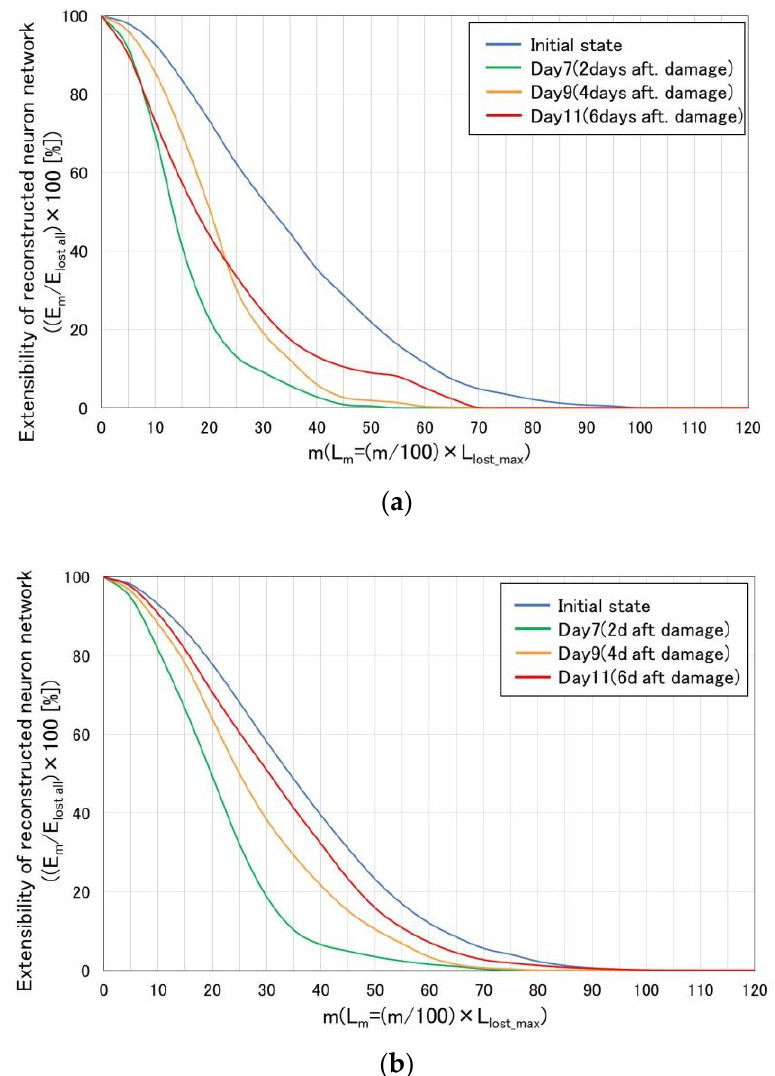
Figure 11. Effect of culture time after cutting damage upon extensibility of reconstructed neurites [=(E m /E lost all ) × 100] in the static case ( a ) and the dynamically stimulated (vibration amplitude:60 µm, frequency:5 Hz, 12 h. interval) case ( b ). The extensibility of the reconstructed neurites in the dynamically stimulated case gradually increases as the culture time increases in the order of 7, 9, 11 days (or 2, 4, 6 days after cutting damage), and reaches closer to the initial state. ( a ) Static case ( n = 6); ( b ) Dynamically stimulated case ( n =